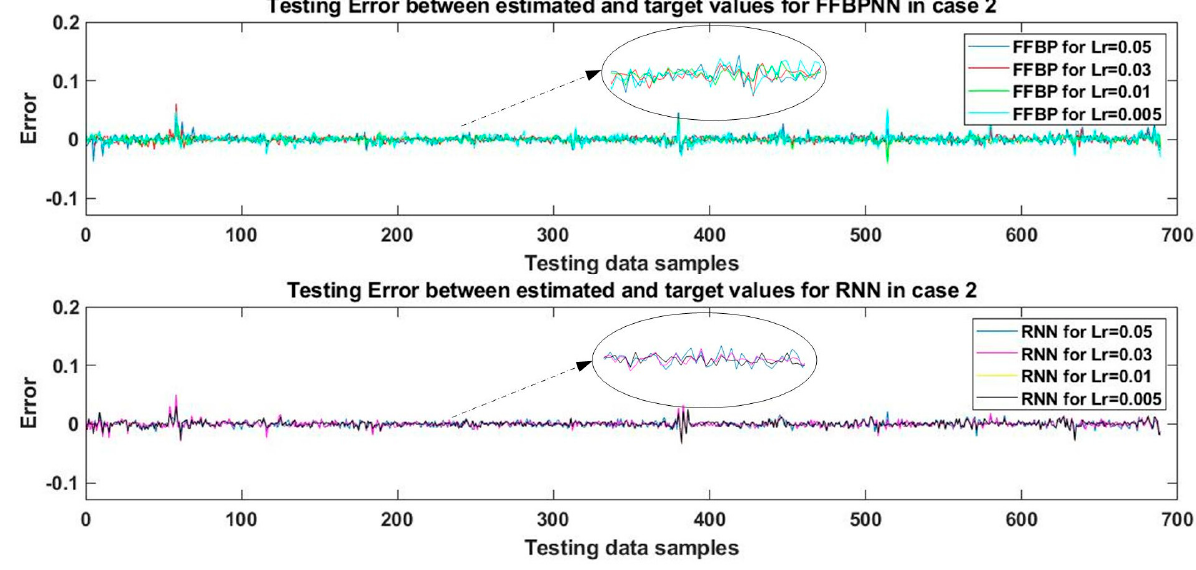
Figure 5. The testing error between estimated and target values for case 2. Table 5. Training and testing results of FFBPNN and RNN for case 2.